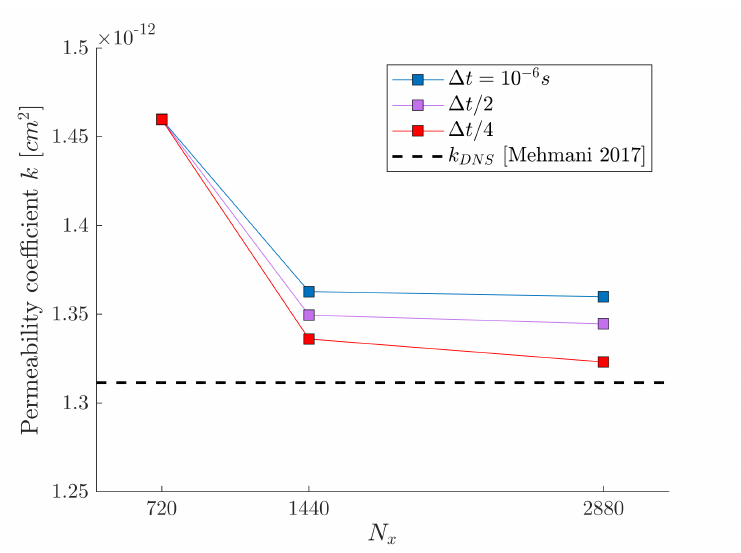
Figure 22. Influence of the grid refinement on the permeability coefficient k